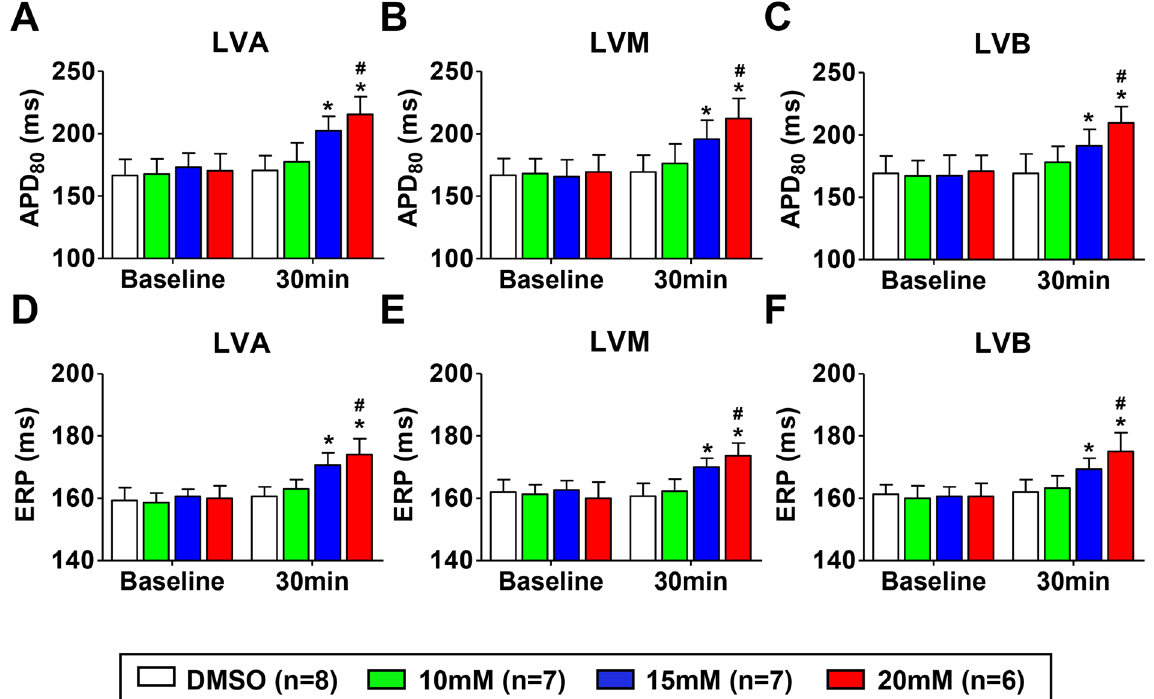
Figure 2. Effects of Nav1.8 channel block on the ventricular APD 80 ( A–C ) and ERP ( D–F ). Blocking Nav1.8 channel with A-803467 significantly prolonged ventricular APD 80 and ERP, whereas no significantly change was found in the DMSO group. * p < 0.05 vs DMSO group at 30 min, # p < 0.05 vs 10 mM group at 30 min. The abbreviations were similar with Fig. 1.